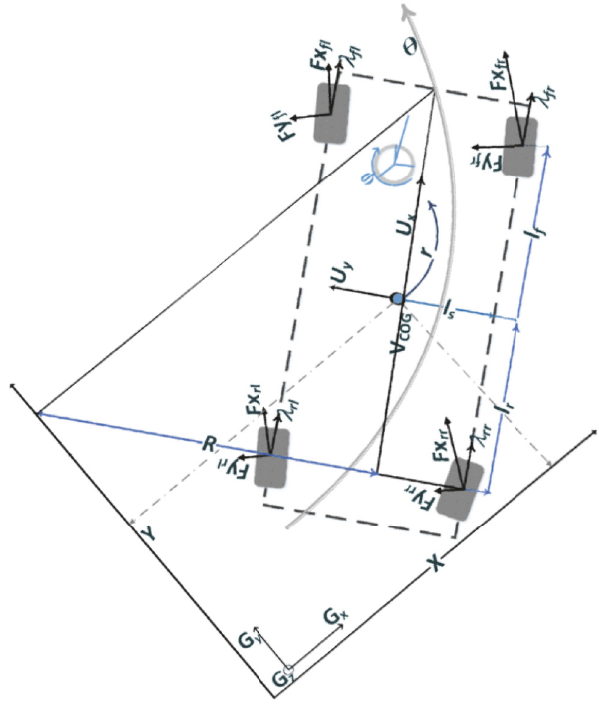
Figure 1: Differential Speed Steer EV maneuvering a